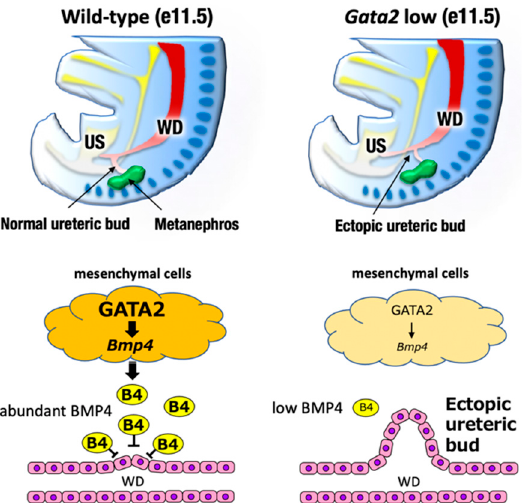
Figure 4. The definitive kidney development begins around e11 when the ureteric bud (UB) sprouts from the posterior WD. Bone morphogenetic protein 4 (BMP4), which is secreted by the urogenital mesenchymal cells surrounding the UB, prevents the aberrant outgrowth of the UB from rostral ectopic sites on the WDs. GATA2-low mice failed to express sufficient level of BMP4. Consequently, the ureteric budding is mislocated in the rostral position of Wolffian duct, which compromise the ureter-bladder connection.